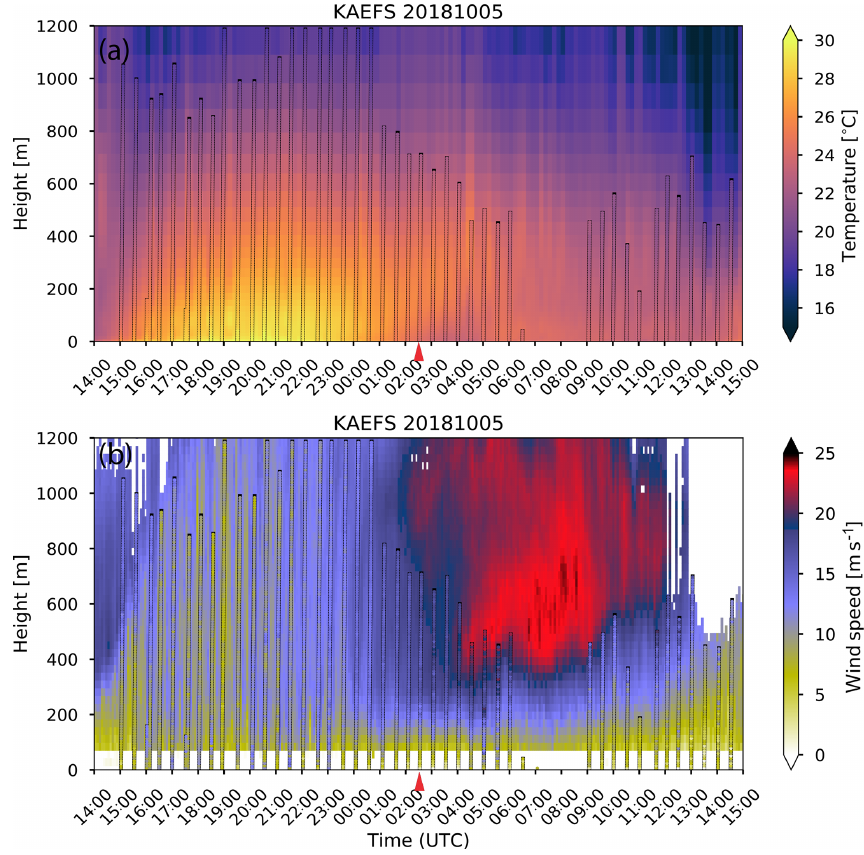
Figure 13. Same as Fig. 11 but for 5–6 October 2018 during the Flux Capacitor campaign. These time heights contain data from the entire observation period.